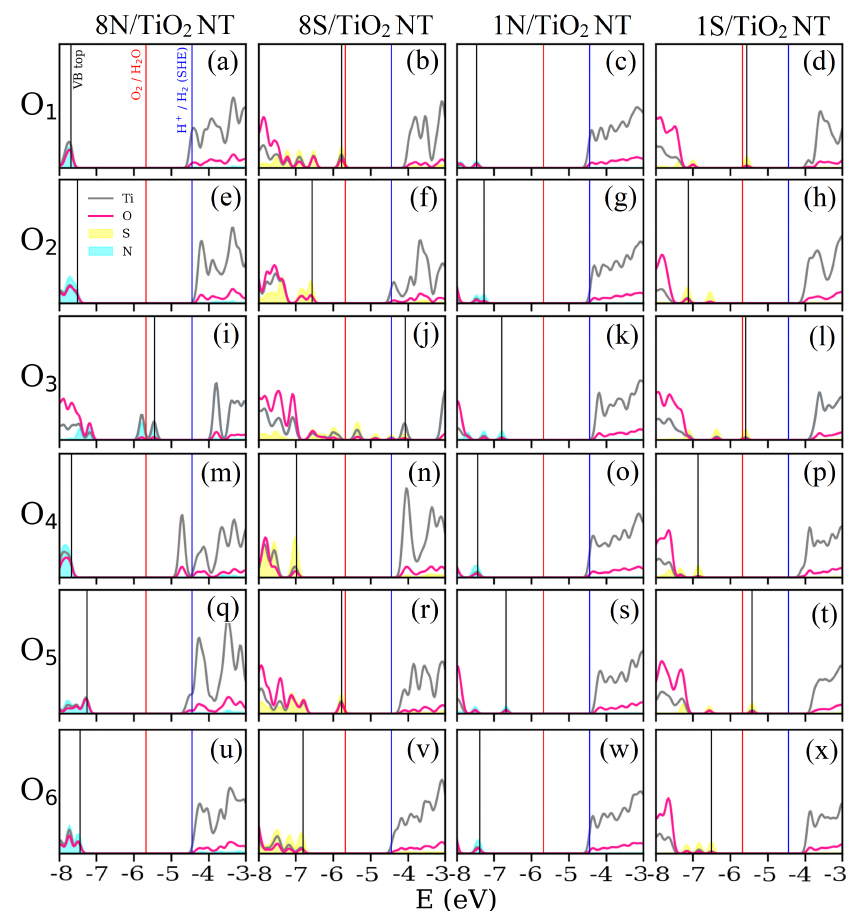
Figure 2. Projected density of states (PDOS) of the N- (cyan) or S- (yellow) doped TiO 2 NT. Each row corresponds to the numbered host oxygens substituted by dopant (O 1 to O 6 ); each column represents the total number of doped atoms (8N, 8S, 1N, 1S). ( a ) 8N/TiO 2 NT at O 1 ; ( b ) 8S/TiO 2 NT at O 1 ; ( c ) 1N/TiO 2 NT at O 1 ; ( d ) 1S/TiO 2 NT at O 1 ; ( e ) 8N/TiO 2 NT at O 2 ; ( f ) 8S/TiO 2 NT at O 2 ; ( g ) 1N/TiO 2 NT at O 2 ; ( h ) 1S/TiO 2 NT at O 2 ; ( i ) 8N/TiO 2 NT at O 3 ; ( j ) 8S/TiO 2 NT at O 3 ; ( k ) 1N/TiO 2 NT at O 3 ; ( l ) 1S/TiO 2 NT at O 3 ; ( m ) 8N/TiO 2 NT at O 4 ; ( n ) 8S/TiO 2 NT at O 4 ; ( o ) 1N/TiO 2 NT at O 4 ; ( p ) 1S/TiO 2 NT at O 4 ; ( q ) 8N/TiO 2 NT at O 5 ; ( r ) 8S/TiO 2 NT at O 5 ; ( s ) 1N/TiO 2 NT at O 5 ; ( t ) 1S/TiO 2 NT at O 5 ; ( u ) 8N/TiO 2 NT at O 6 ; ( v ) 8S/TiO 2 NT at O 6 ; ( w ) 1N/TiO 2 NT at O 6 ; ( x ) 1S/TiO 2 NT at O 6 . Vertical lines crossing all the DOS plots correspond to VBM of the doped TiO 2 NT (black), while red lines and blue lines correspond to the O 2 /H 2 O and H + /H 2 redox potentials positioned with respect to the vacuum level, respectively. The PDOS peaks of dopants are scaled by the factor of